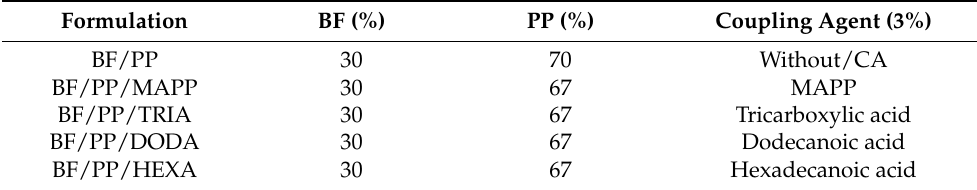
Table 1. Formulations of composites.